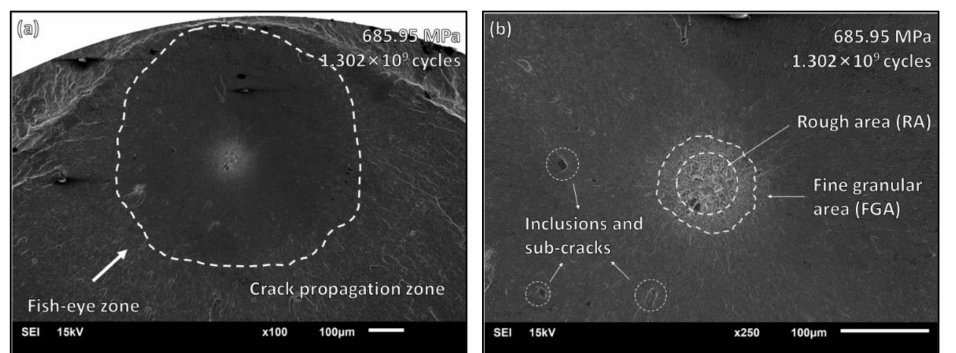
Figure 7. VHCF fracture morphology: ( a ) fish-eye zone from internal cracks, which stops propagation when reaching the surface of the specimen; ( b ) rough area and fine granular area. There are other inclusions around the crack initiation site where sub-cracks are